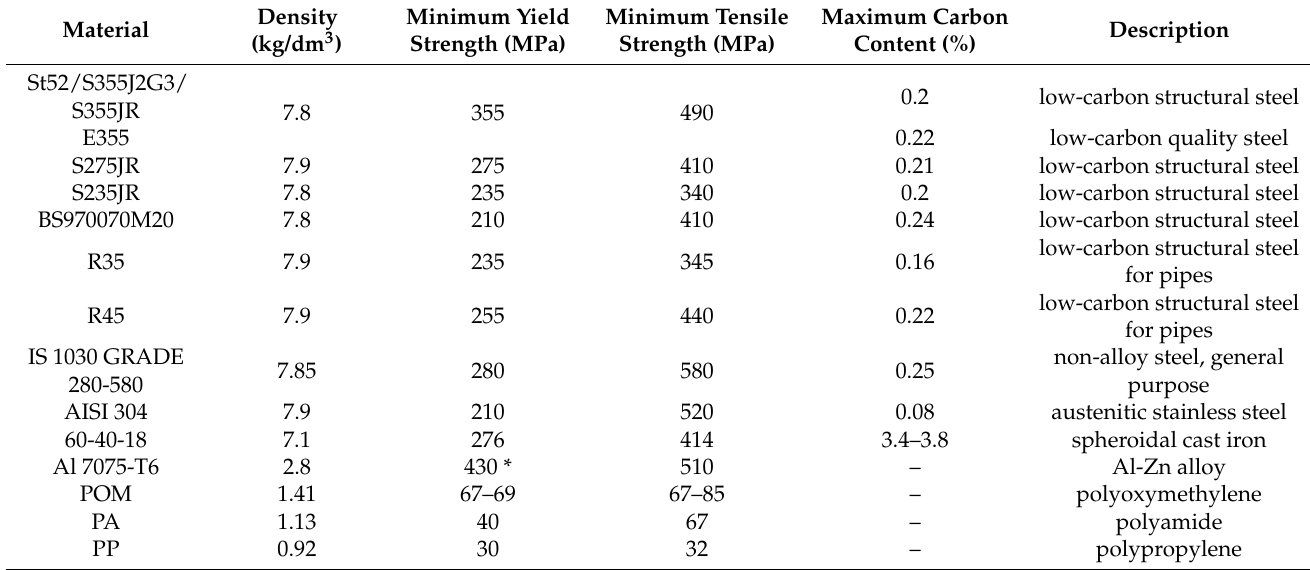
Table 1. Basic properties of the materials used for